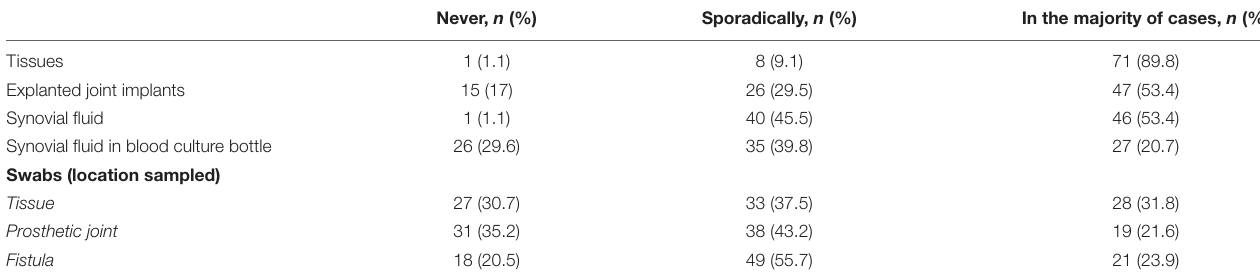
TABLE 2 | Type of samples received in clinical microbiology